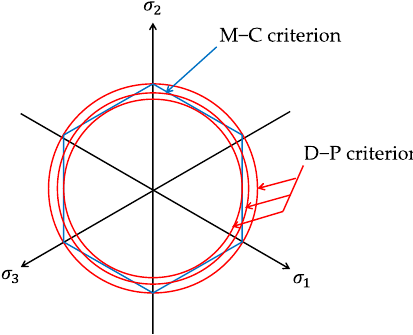
Figure 2. Yield surfaces of the M–C and D–P criteria on the deviatoric plane.